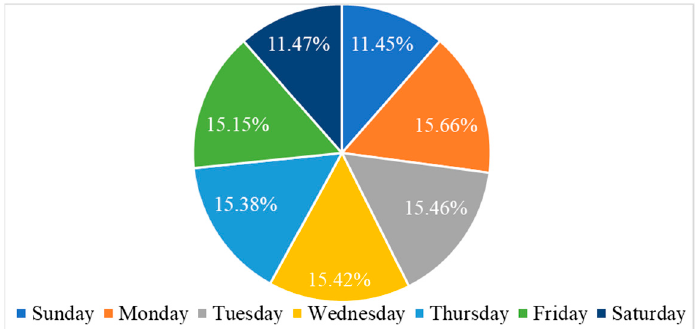
Figure 5. Energy consumption classification per day of the week.